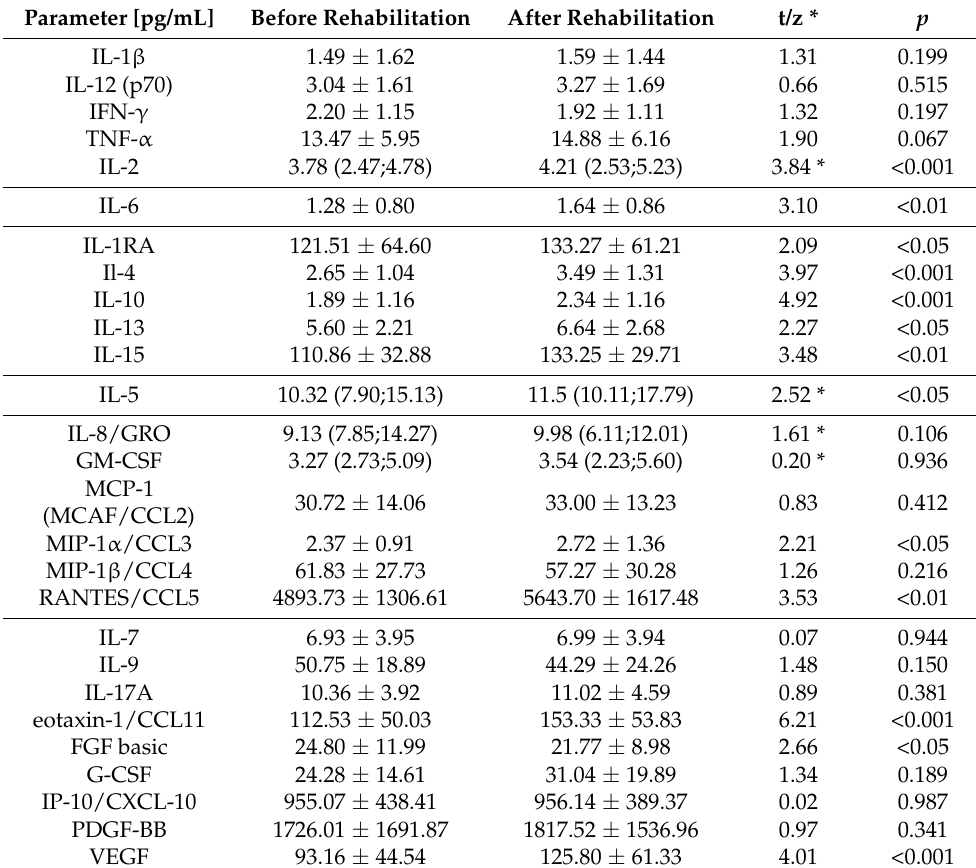
Table 1. The levels of interleukins and cytokines in the serum of patients after hip or knee replacement in the course of osteoarthritis before and after the 21-day general rehabilitation program. Parameter [pg/mL] Before Rehabilitation After